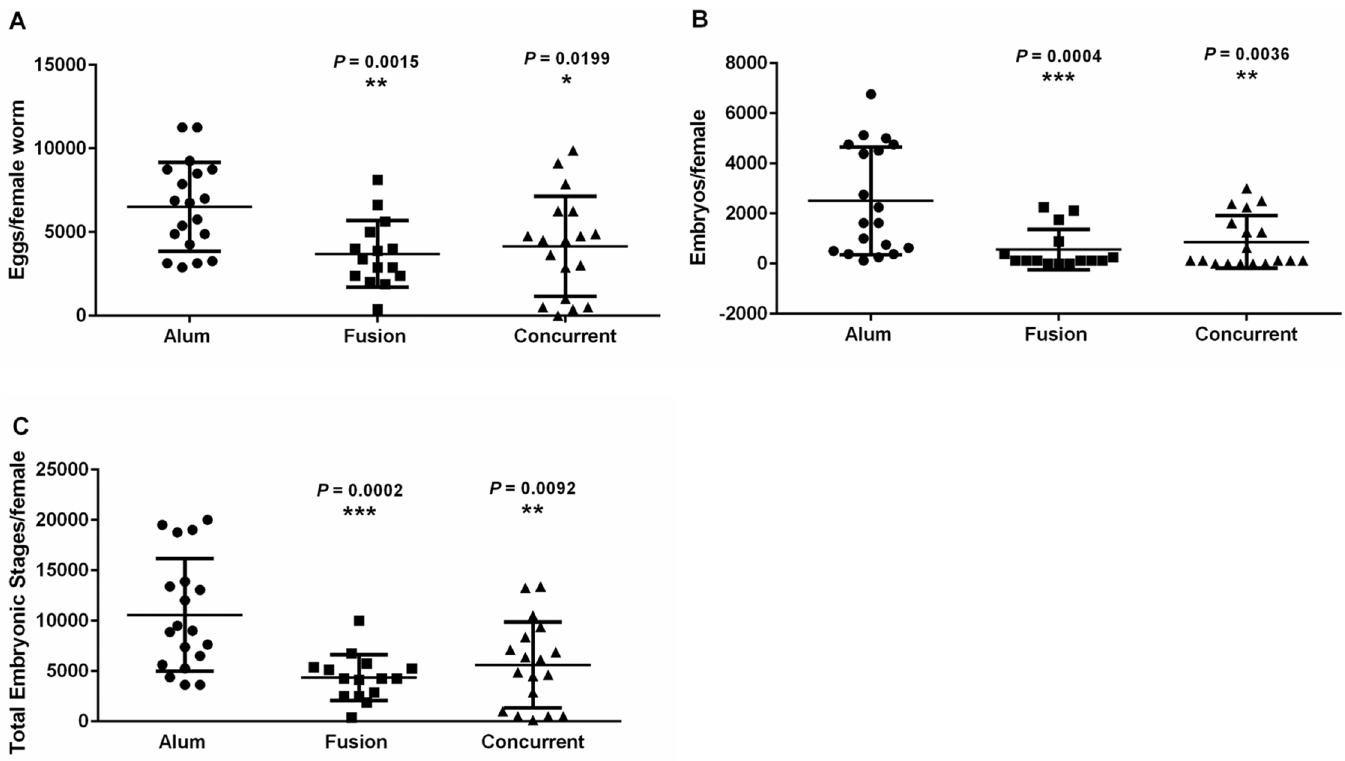
Fig 5. Embryogram data of B . malayi female worms recovered 150 dpi from alum control, Bm -103 + Bm -RAL-2 and Bm -103 — Bm -RAL-2 vaccinated gerbils. (A) Eggs/female worm; (B) Embryos/female worm; (C) Total embryonic stages/female worm. Statistical significance was determined by Mann – Whitney U Test using GraphPad Prism version 6, asterisks denotes a significant difference between the alum control and the vaccinated group, P (cid:1) 0.05. The line represents mean with standard deviation.